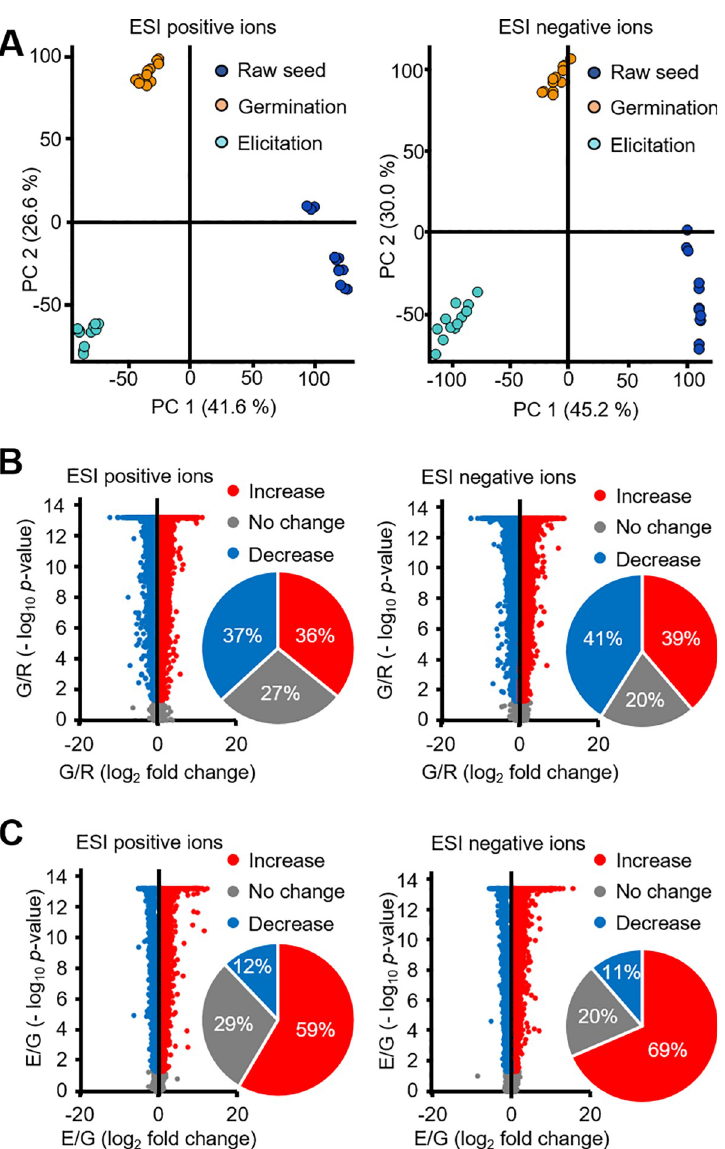
Fig 2. PCA and volcano plot analysis of the detected MS peaks in raw seed, germination, and elicitation samples. (A) PCA of raw seed, germination, and elicitation samples. Volcano plots and comparison of change ratios between (B) raw seed and germination samples and (C) germination and elicitation samples. 678 compounds were classified into 12 metabolic groups (Al, Am, C, F, L, M, N, P, S, T, V, and O groups; Fig 3 and S1 Table) and nine patterns of change between raw and germinated soy- bean as well as between germinated and elicited germinated soybean (groups 1–9; Fig 3 and S1 Table). With the exception microbial and other metabolic groups, the content and number of flavonoid group metabolites were the highest in group 1 (12.7%, 17 metabolites), 4 (16.8%, 19 metabolites), and 7 (15.3%, 37 metabolites), whose levels were increased by elicitation (Fig 3, pie chart). The average change ratios of these flavonoid group metabolites due to germination and elicitation were 3.1- and 9.1-fold in group 1, 0.9- and 94.4-fold in group 4, and 0.3- and 35.0-fold in group 7, respectively (Fig 3, heat map).